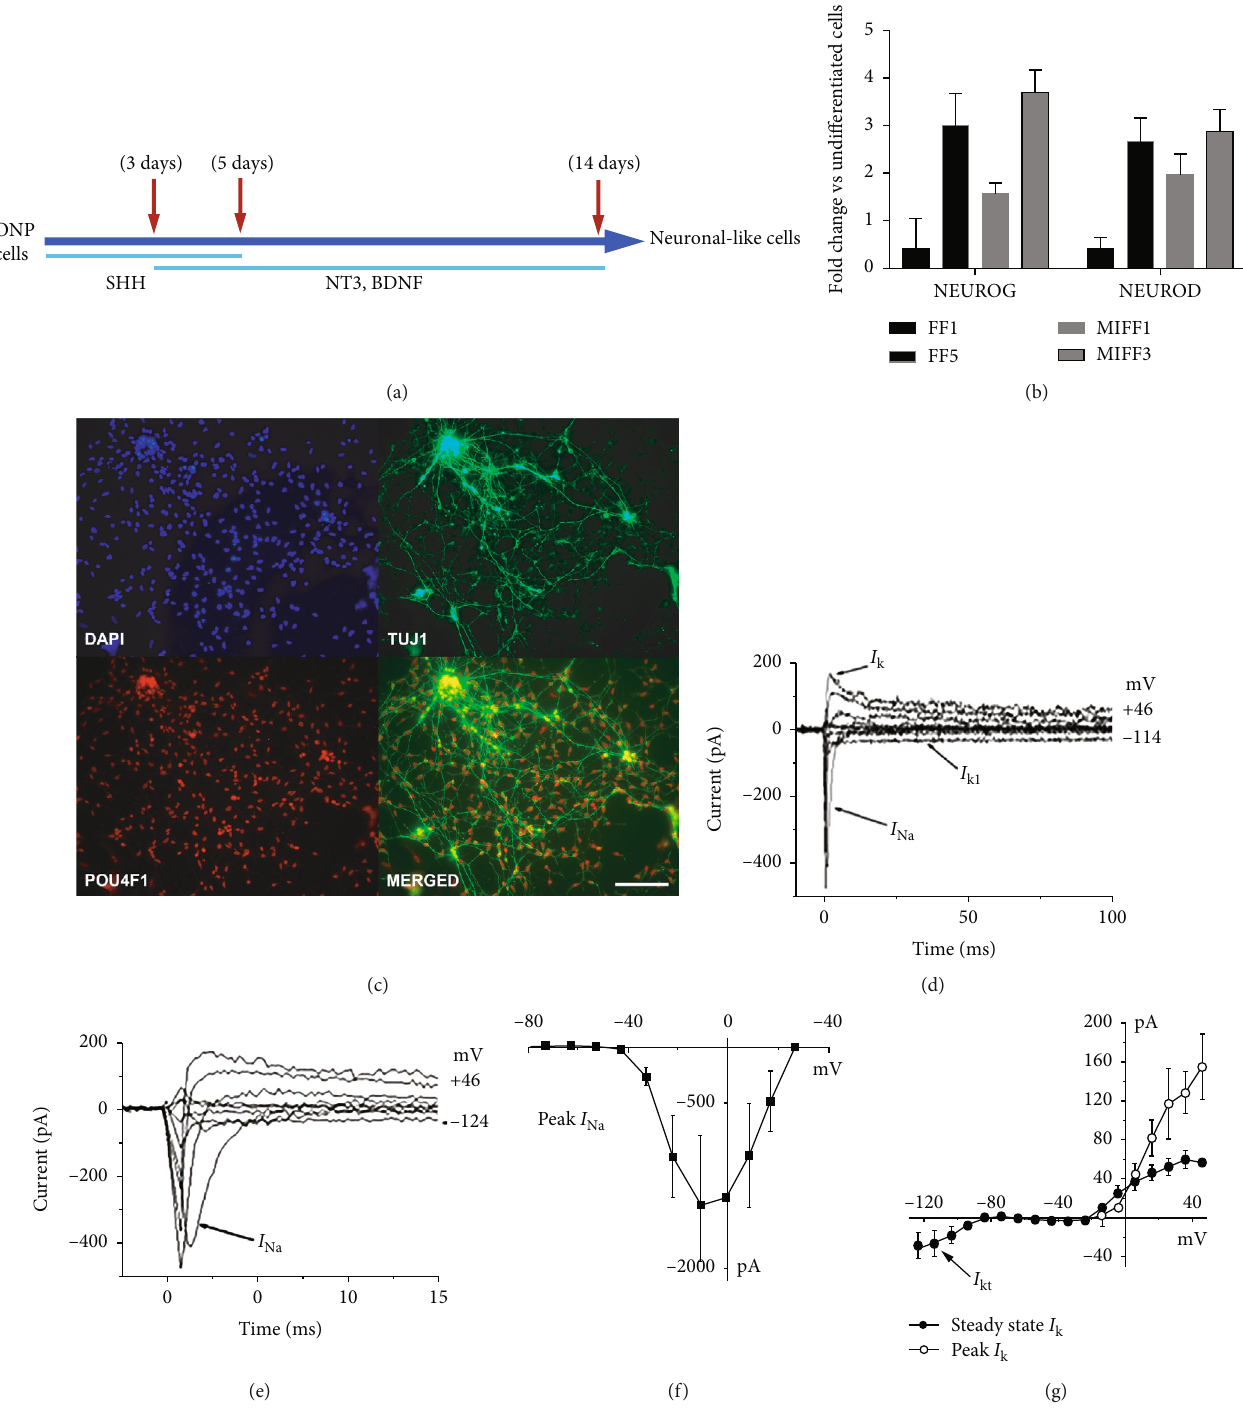
Figure 2: (a) Diagram showing the protocol for the generation of spiral ganglion-like neurons. (b) qPCR showing relative expression levels of NEUROG and NEUROD. Data shown as fold change against undi ff erentiated cells from the same initial population. (c) ONPs di ff erentiating into neurons express markers such as TUJ1 and POU4F1, scale bar is 200 μ m. Immuno fl uorescence images shown are from cell line FF5. (d) Electrophysiological properties of di ff erentiating neuronal-like cells. Depolarizing and hyperpolarizing voltage steps in 10mV nominal increments from a holding potential of -84mV revealed Na + currents ( I Na ; (d), expanded in (e)) in 3 out of 3 neuronal-like cells, small outward K + currents ( I K ; (d)) in 3 out of 3 cells and a small inward K + current ( I K1 ) in 1 out of 3 cells (d). The peak I - V curve for I Na indicates that I Na activated at potentials near -40 mV and reached a maximum size of 1328 ± 634 pA near -10 mV ( n = 3 ; (f)). The steady state I - V curve for I K was also generated from a holding potential of -84mV, and the current size at 0mV and measured at 160 ms was 32 ± 10 pA, n = 3 (g). The small inward K + current ( I K1 ) was evident for membrane potentials negative to -80 mV